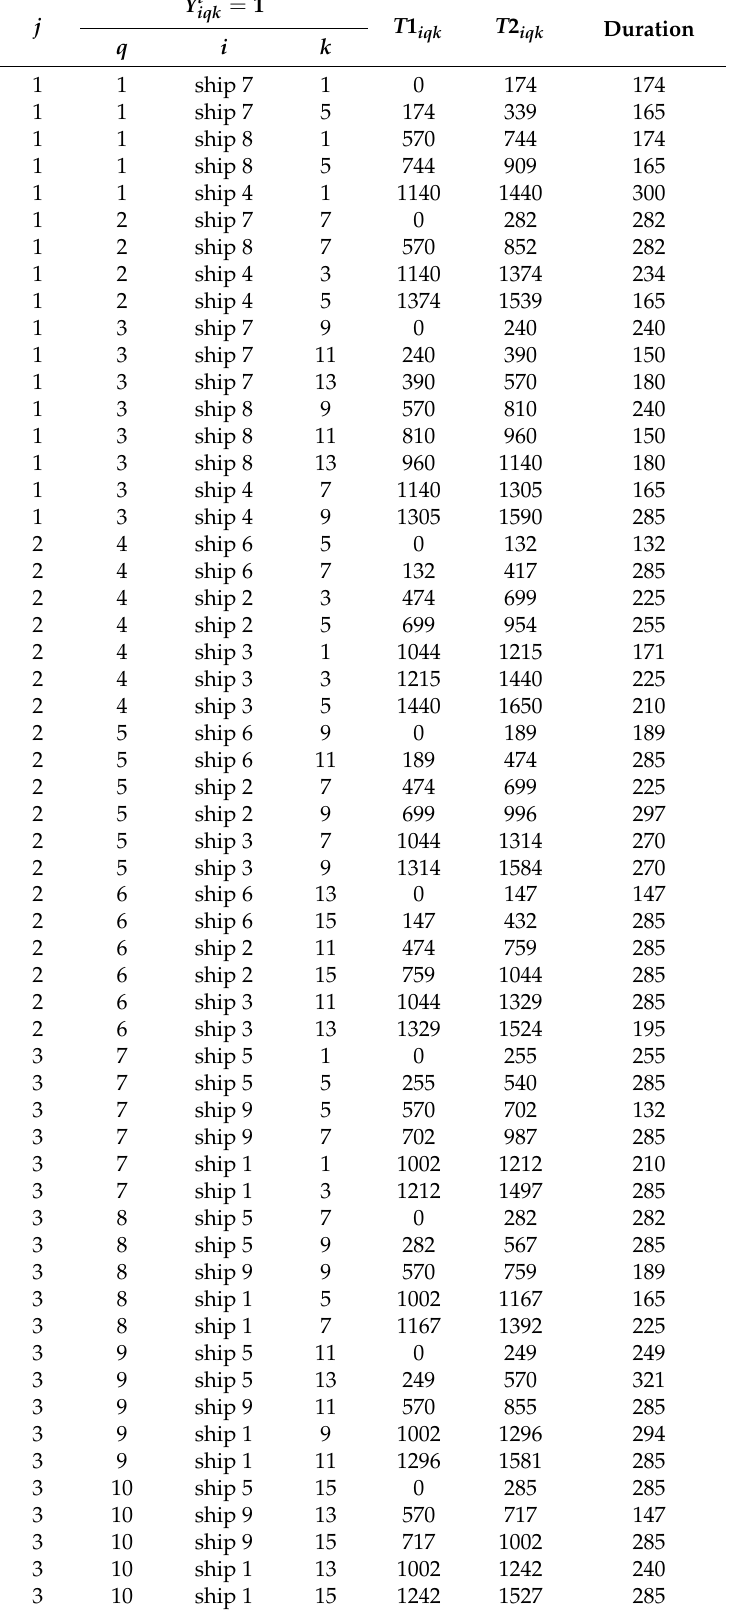
Table 2. The schedule of QCs (sorted by QC